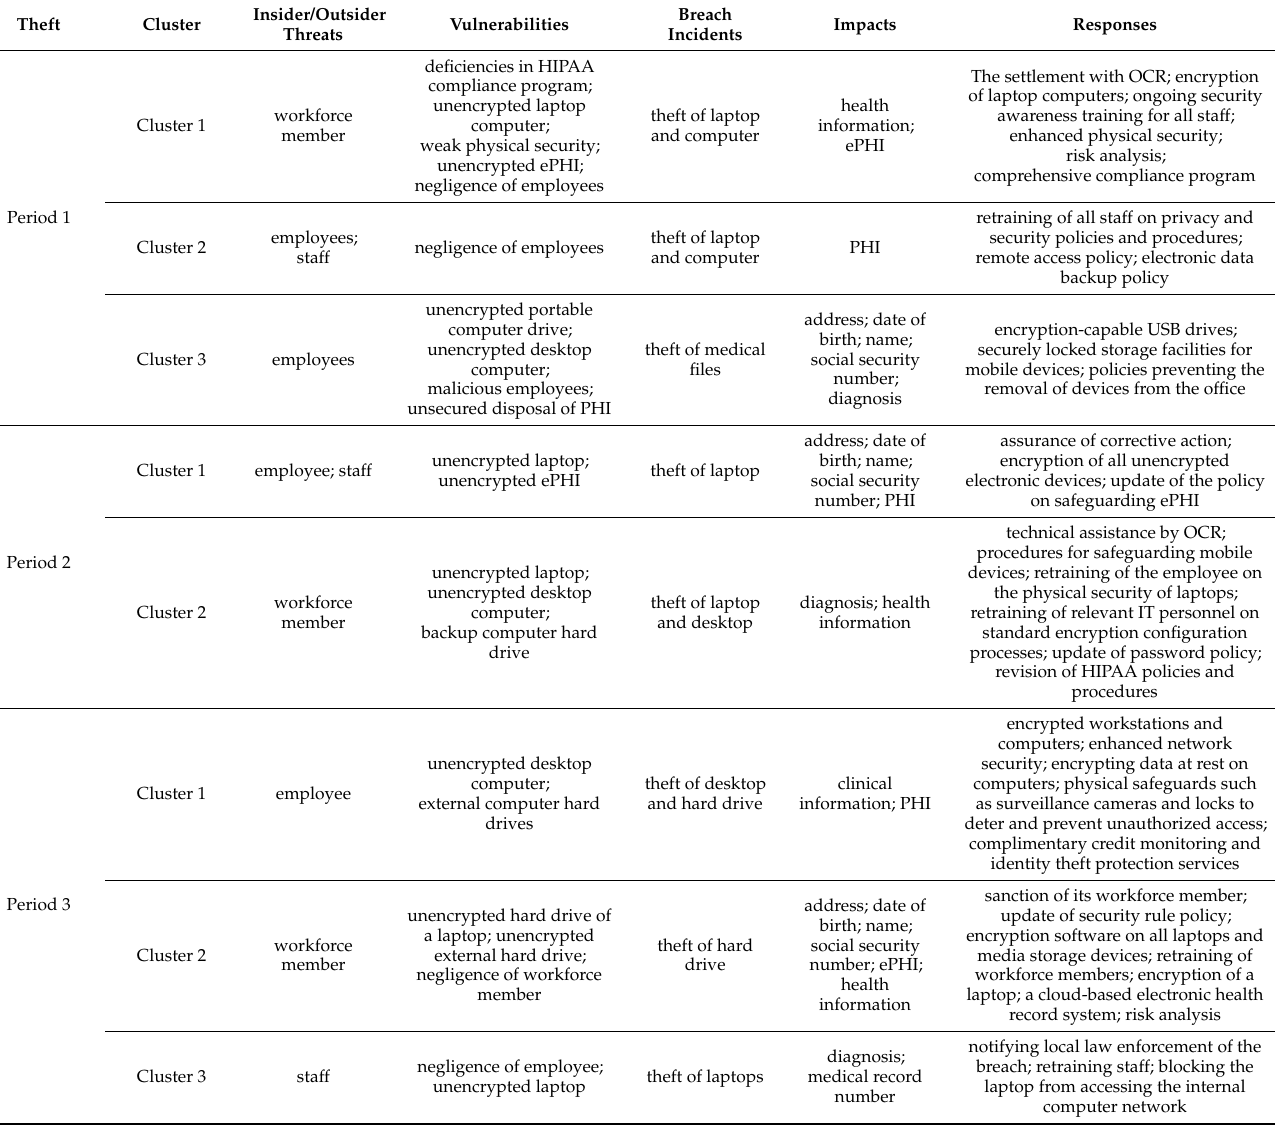
Table 4. Insider/Outsider Threats, Vulnerabilities, Breach Incidents, Impacts, and Responses in